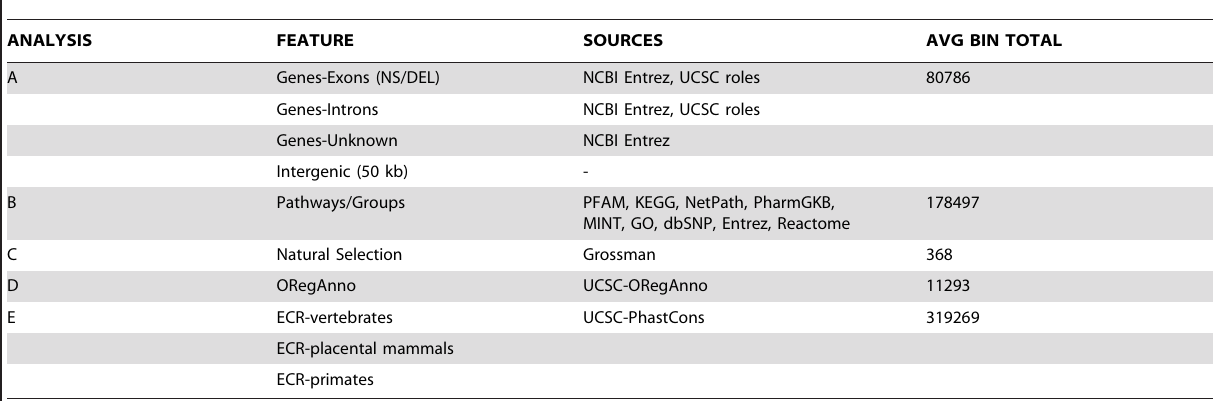
Table 2. Binning analysis